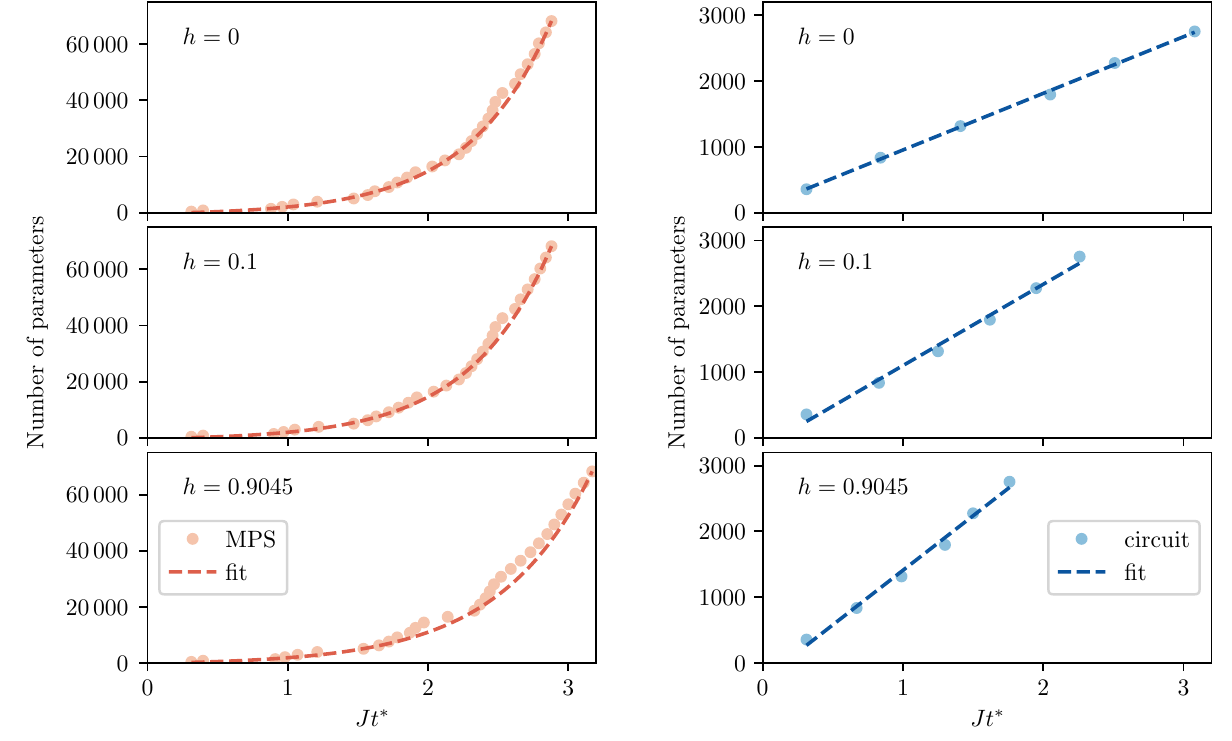
∗ + FIG. 12. (a) We fit the MPS data with f ( Jt ∗ ) = ae bJt c and obtain the (a)–(c) parameters for h = 0, ( 540, 1.69, − 910 ) , h = 0.1, ( 506, 1.71, − 836 ) , and h = 0.9045, ( 559, 1.52, − 711 ) , respectively. Note that we fit only the data points with bond dimension being power of 2, i.e., χ = 2 n , n ∈ Z + . (b) We fit the quantum-circuit data with f ( Jt ∗ ) = a × ( Jt ∗ ) + b and obtain (a),(b) parameters for each case, h = 0, ( 861, 91 ) , h = 0.1, ( 1236, − 138 ) , and h = 0.9045, ( 1659, − 251 ) ,